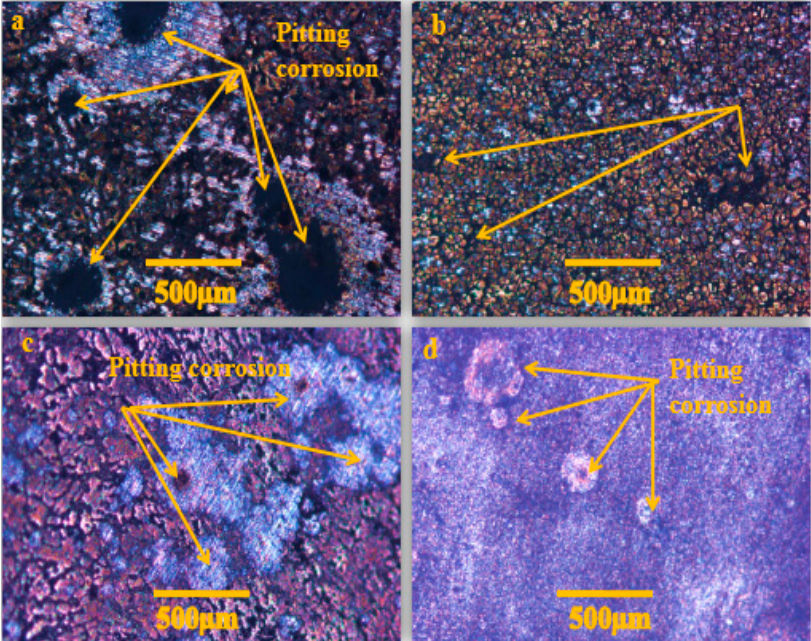
Figure 7. Surface appearance of A356 alloy ( a ) as-cast, ( b ) cooling slope ( c ) ECAPed as-cast-T6 after 4 passes and ( d ) ECAPed cooling slope-T6 after 6 passes after immersion for 10 days.